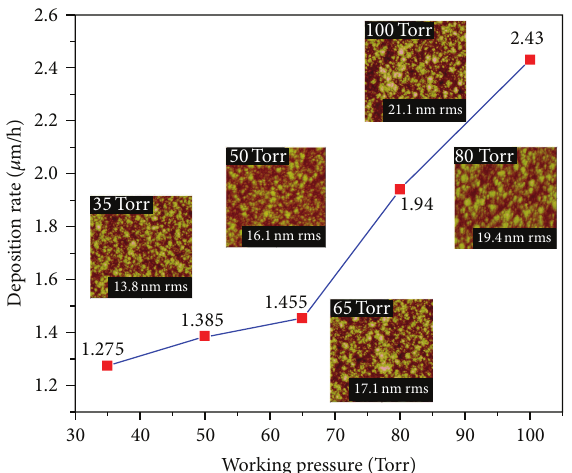
Figure 3: The dependence of deposition rate and surface roughness of the as-prepared diamond films on the working pressure.